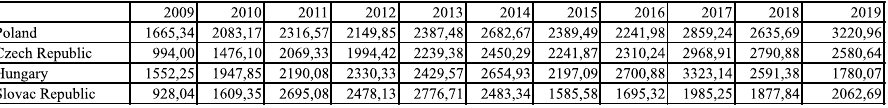
Export to China, 2009–2019, USD,